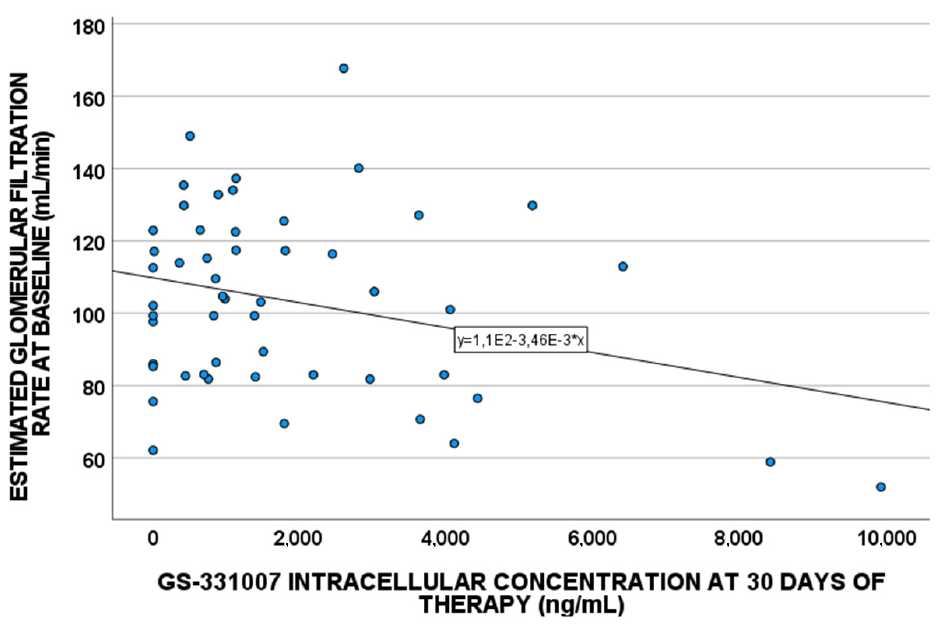
Figure 2. GS-331007 IC levels at 30 days of therapy correlated with baseline estimated glomerular filtration rate in all patients ( p -value = 0.036 and Pearson coefficient = − 0.291). For these reasons, when focusing on the eGFR cutoff value of 60 mL/min [24], which is associated with kidney impairment, a statistically significant influence was highlighted for GS-331007 IC concentrations ( p -value = 0.018, Figure 3) and plasma concentrations ( p - value = 0.032, Figure 4).